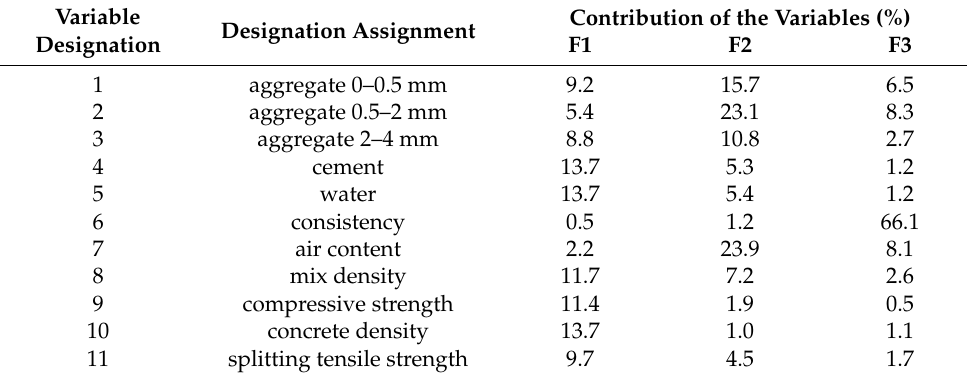
Table 5. Contribution of the variables in PCA